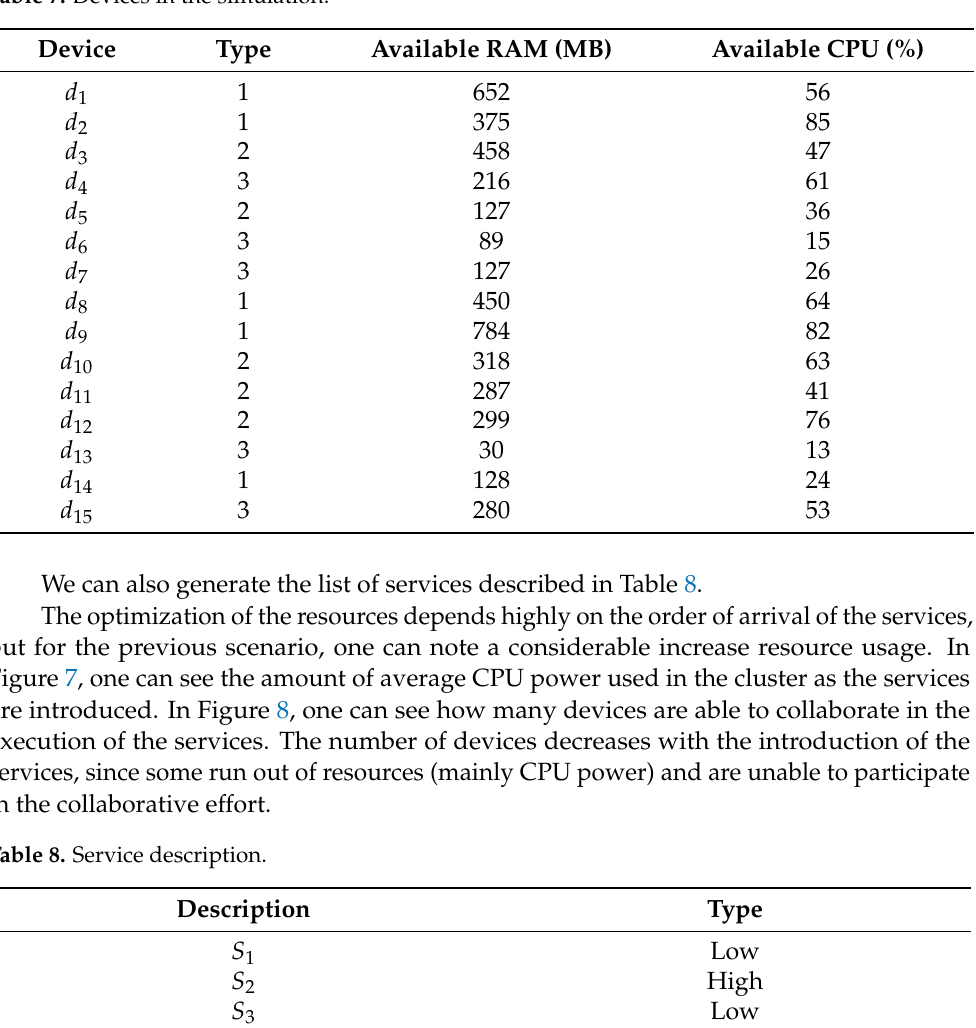
Table 7. Devices in the simulation.